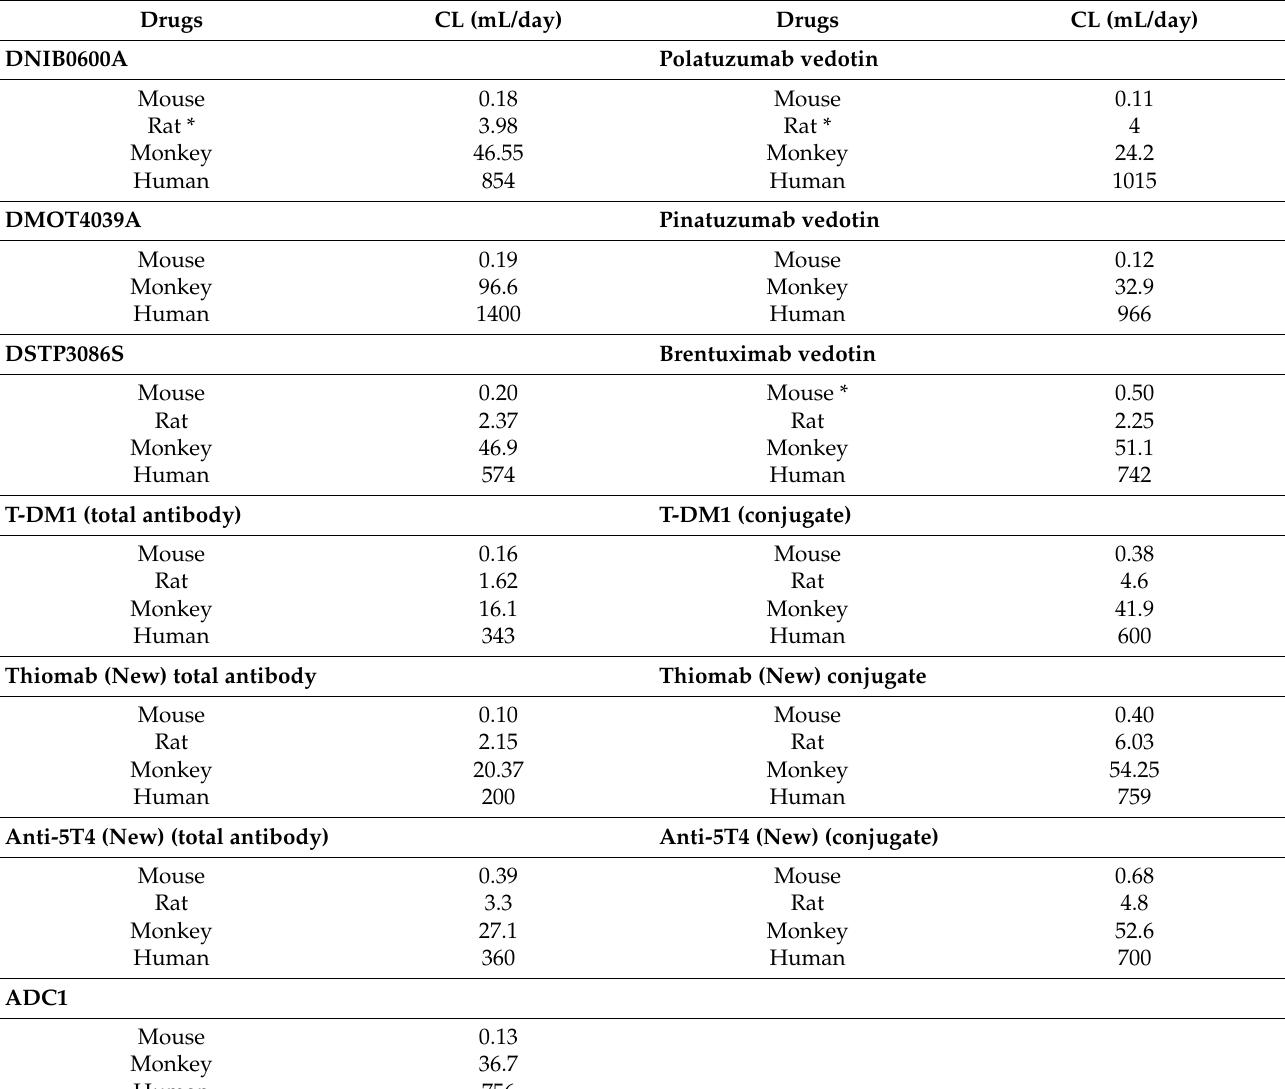
Table 1. Body weight and clearance values for antibody–drug conjugates (ADCs) used in the